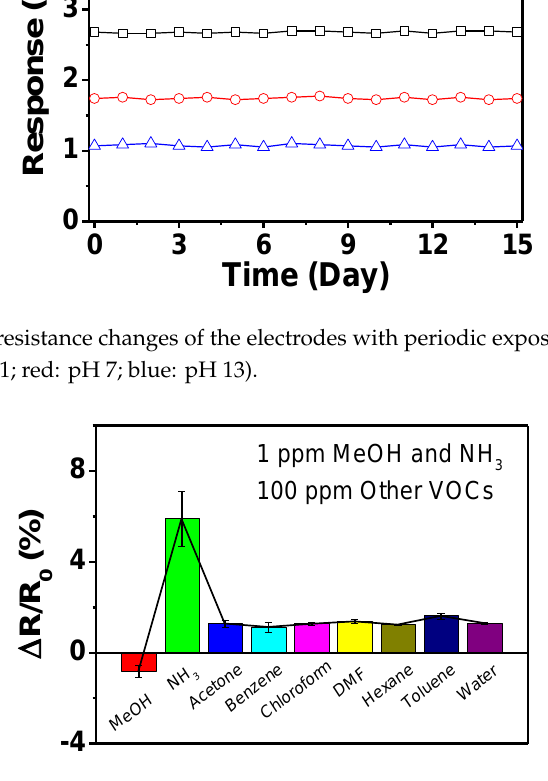
Figure 10. Sensing performance histogram of the PPyNPs treated at pH 1 toward different oxidizing and reducing volatile gases. The concentrations of the gases are 1 ppm for NH 3 and MeOH and 100 ppm for other gases.